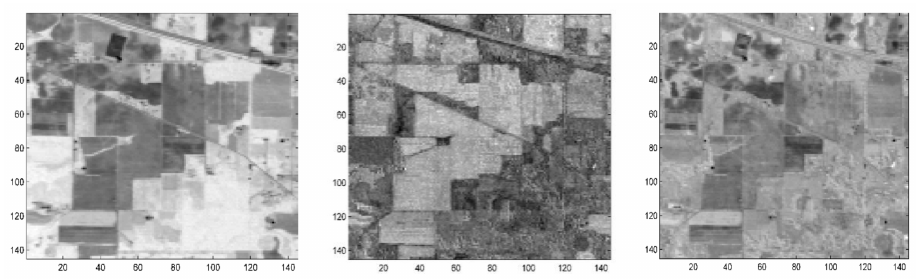
Figure 7. Plot of three arbitrary selected ICs components from the DCT-ICA feature space in the Indian Pines dataset.